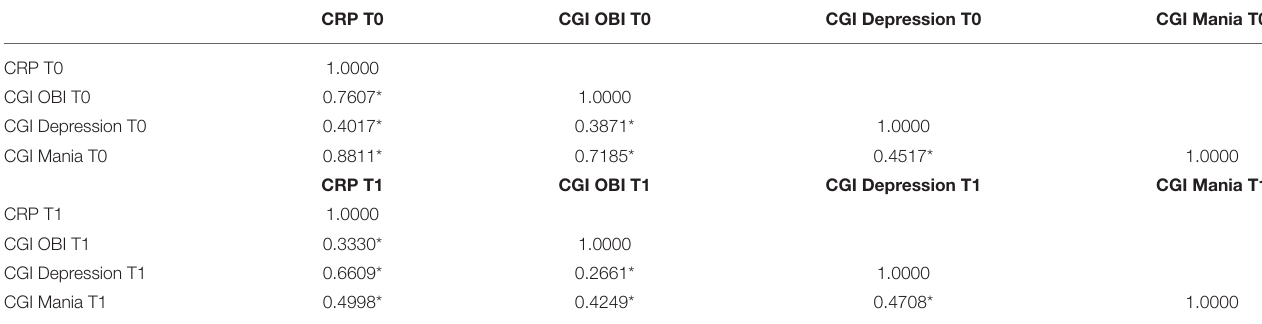
TABLE 2 | Spearman’s correlation coefficient at T0 and